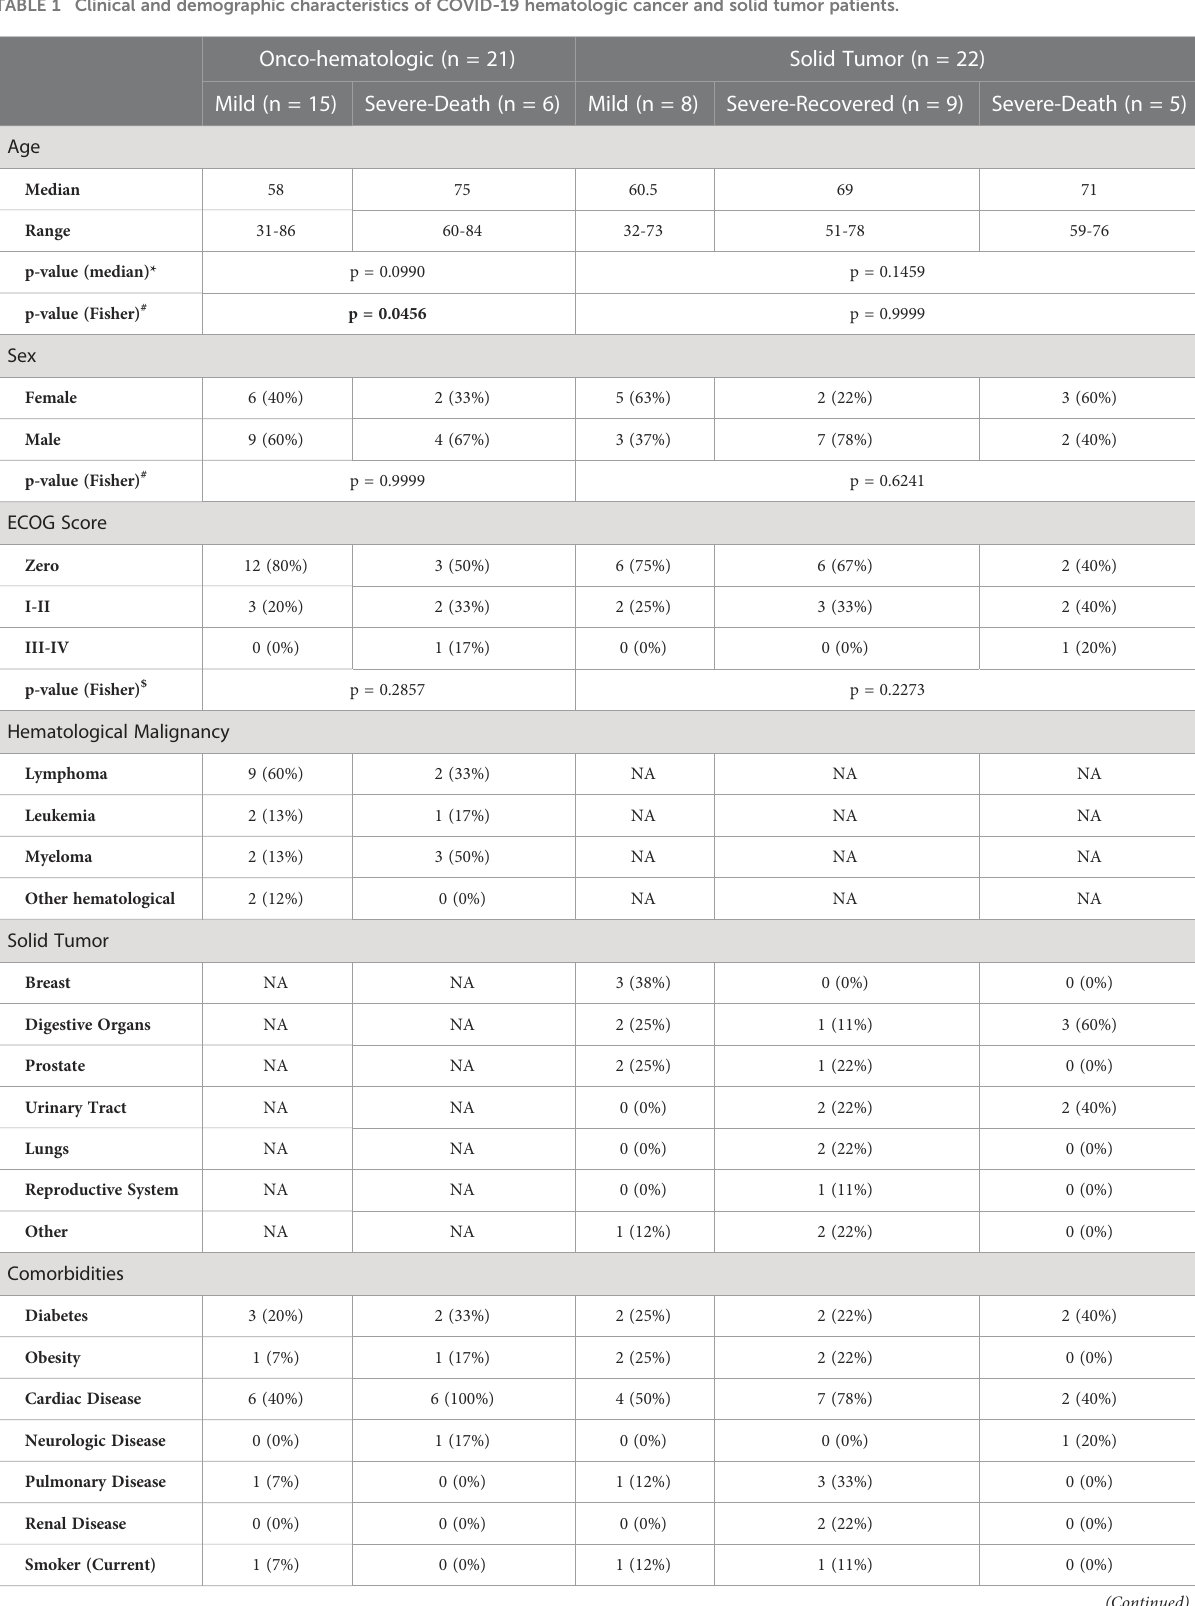
TABLE 1 Clinical and demographic characteristics of COVID-19 hematologic cancer and solid tumor